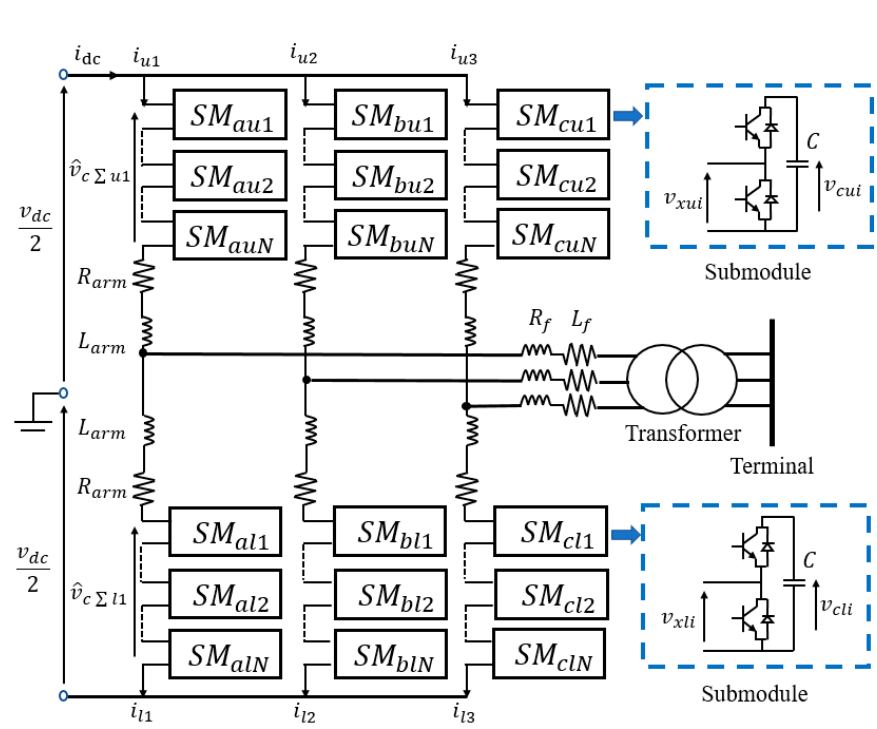
Figure 2. MMC HVDC converter configuration.